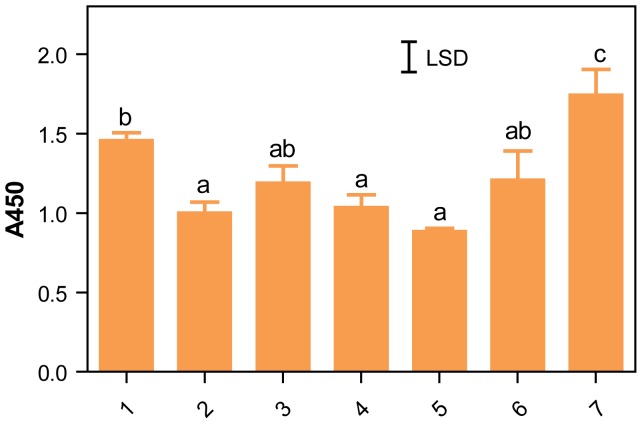
The hordein content of wild type flours varies with variety and environment.The response of ELISA Systems anti-gluten sandwich assays to triplicate 10 ng alcohol soluble protein from different wild type flours. Mean A450±SE is shown for triplicate extracts for cv Sloop grown at CSIRO Ginninderra Experiment Station, Canberra, 1 or Yanco Agricultural Institute (NSW Dept. of Agriculture, Yanco, NSW), 2; cv Himalaya, 3; cv Bomi, 4; cv Carlsberg II, 5; cv Hindmarsh, 6; and cv Commander, 7, all grown at CSIRO Ginninderra Experiment Station, Canberra. Total protein was dissolved in Urea/DTT, the protein content measured, diluted 1/500 with ESD, and duplicate aliquots containing 10 ng of protein in approximately 2 µL added to ELISA wells containing a final volume of 100 µL ESD and the sandwich assay carried out. The untransformed data were analysed by one-way ANOVA and the LSD is shown. Columns with the same letter were not significantly different (GenStat).